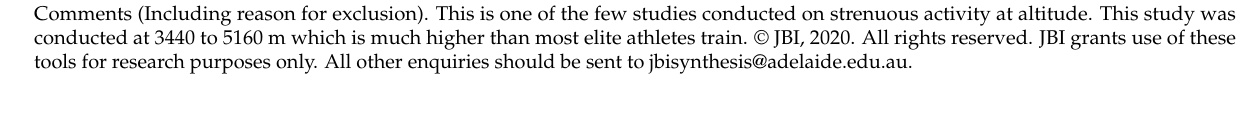
Table A6. JBI Critical Appraisal Checklist for quasi-experimental studies—Huch (1996) study #1. Citation: Huch, R. Physical Activity at Altitude in Pregnancy. Semin. Perinatol. 1996 , 20 , 303–314, doi:10.1016/S0146-0005(96)80023-1.